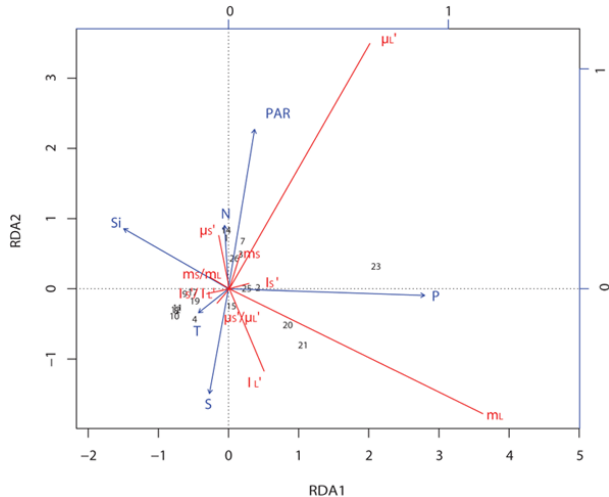
Fig. 5. RDA biplot showing the relationship between the 9 inde- pendent variables (red lines; Table 2) and the environmental factors (blue arrows; N: nitrite + nitrate concentration; PAR: photosyn- thesis active radiation; P: phosphate concentration; S : salinity; Si: silicate concentration; T : temperature). The bottom and left-hand scales are for the sampling stations (black numbers; Table A1) and the response variables (red lines); the top and right-hand scales are for the explanatory variables (blue arrows). The environmental fac- tors offer nearly significant explanation of the biological features ( r = 0 . 506; p = 0 . 061). The first axis explains 46.13%, and the sec- ond axis explains 2.39% of the variance. The first axis is associated with µ 0 and m L and is mainly positively contributed by phosphate L